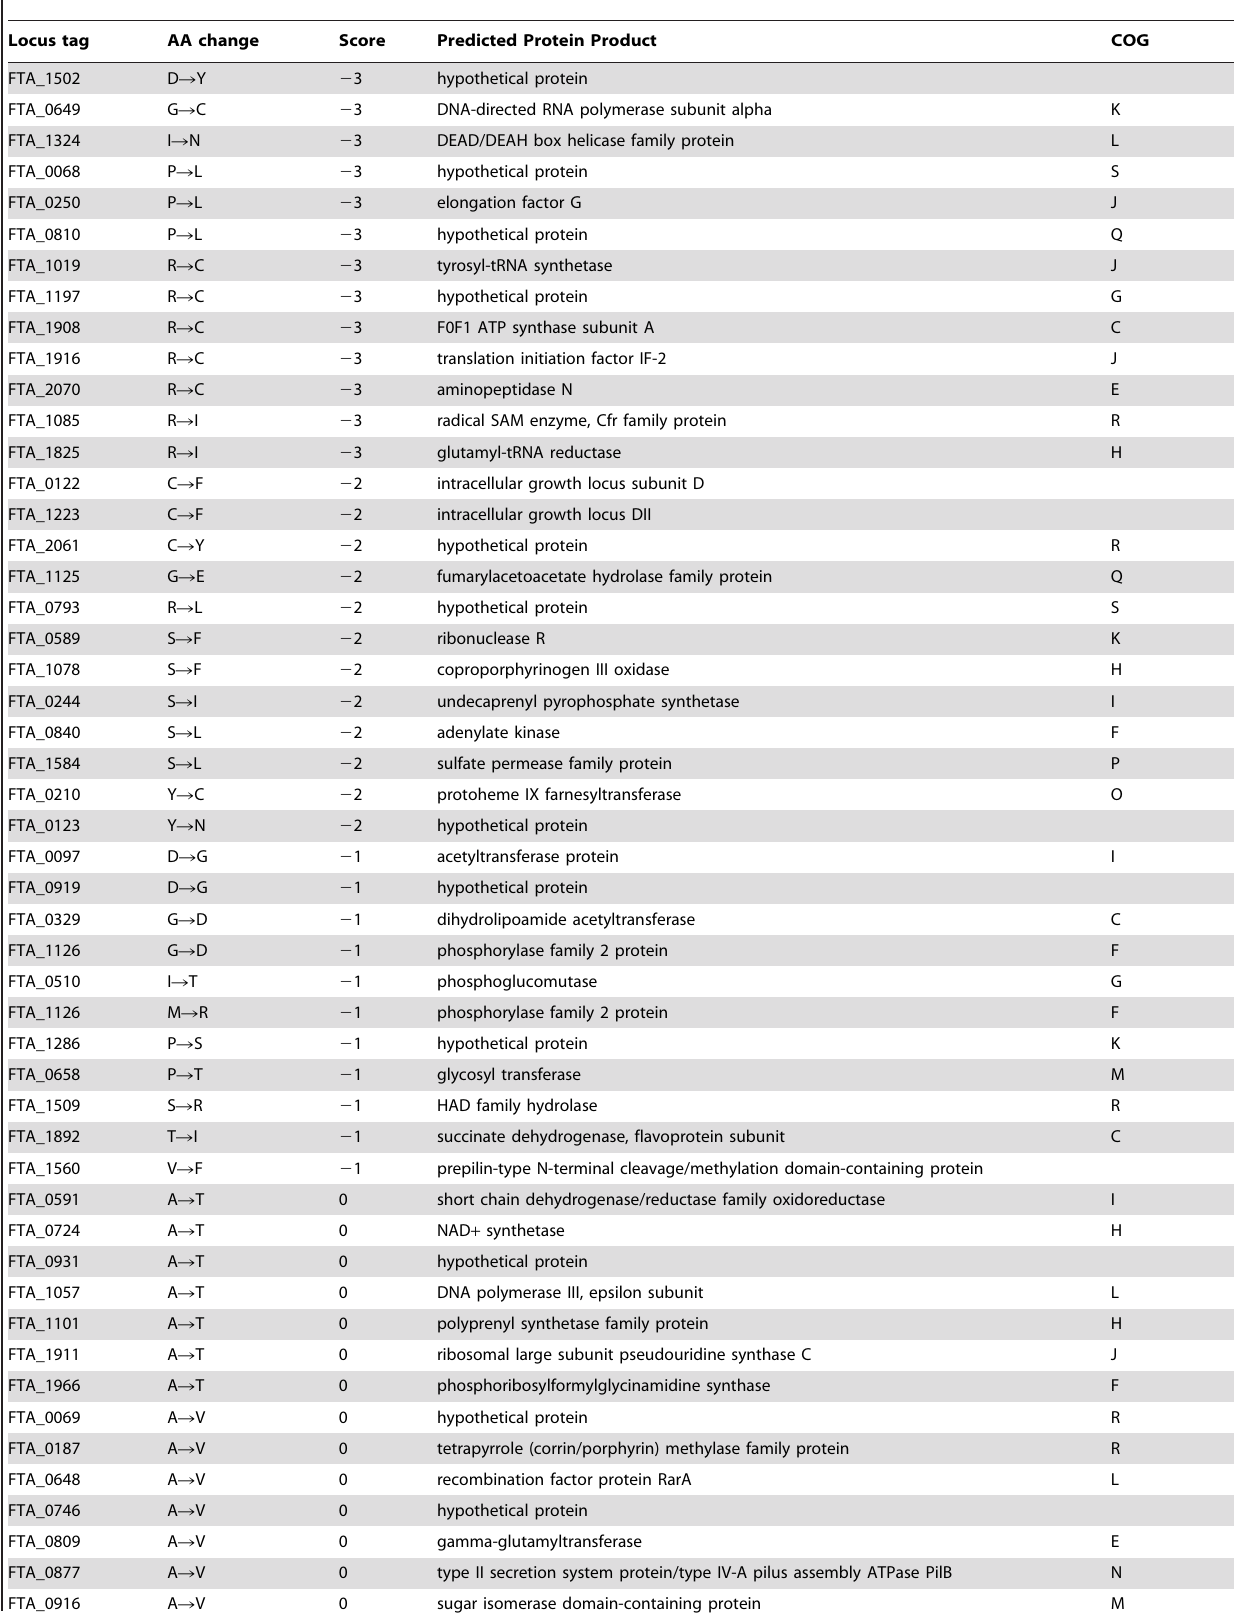
Table 4. List of 99 FTNF002-00 proteins with amino acid mutations compared to LVS and OSU18.